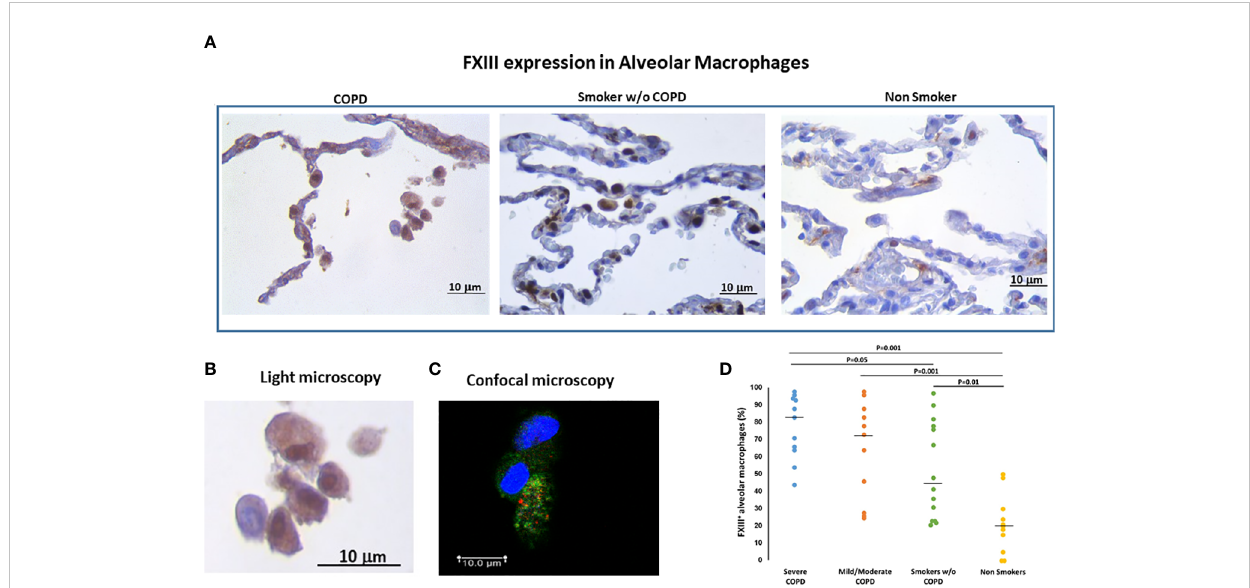
FIGURE 1 FXIIIA expression in alveolar macrophages (AM). (A) Immunohistochemistry of FXIIIA+AM in clusters of alveolar macrophages in smokers with and without COPD and non-smokers. FXIIIA immunoreactivity appears as a brown diffuse cytoplasmic granular pattern. (B) Enlargement of alveolar macrophages in COPD and (C) confocal macrophage images to show the cytoplasmic localization of FXIII: nuclei stained with DRAQ5 (blue), FXIIIA (green), CXCR3 (red). Scale bars= Bars: 10 m m. (D) Percentage of FXIIIA+AM over total AM in smokers with severe COPD (blue circles), mild/ moderate COPD (orange circles), smokers without COPD (green circles) and non-smokers (yellow circles). Horizontal bars represent median values. Overall comparison by Kruskal-Wallis test (p<0.001) with Dunn ’ s multiple comparison